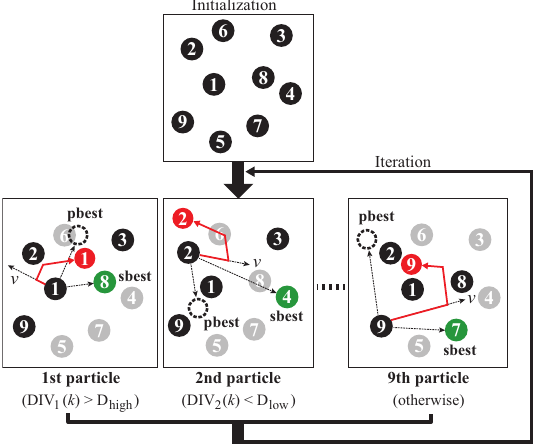
Figure 1. Schematic diagram of the proposed diversity-guided particle swarm optimizer (PSO) with a cyclic network